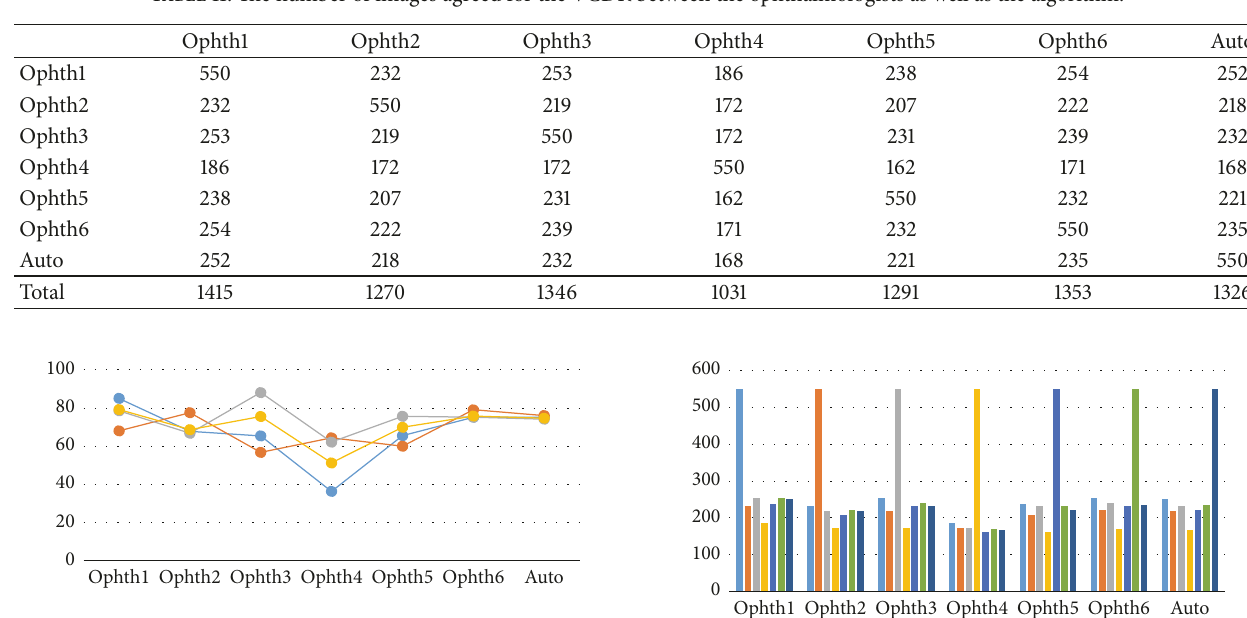
Table 11: The number of images agreed for the VCDR between the ophthalmologists as well as the algorithm.